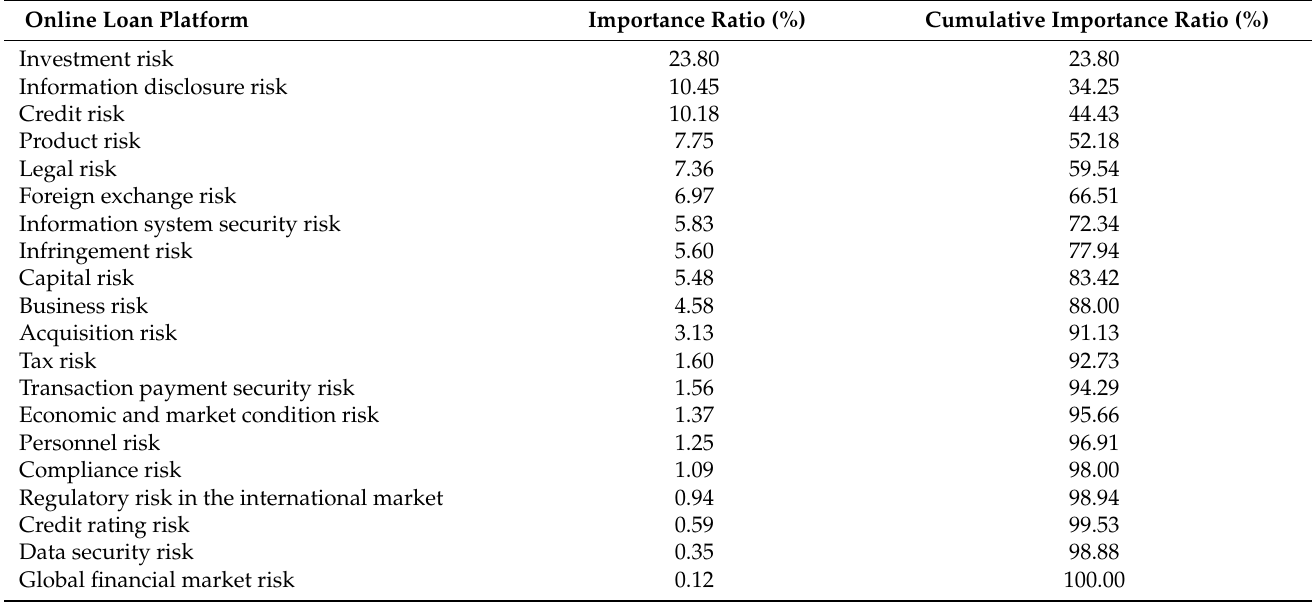
Table 12. The importance of risks faced by the online loan platform industry from 2015 to